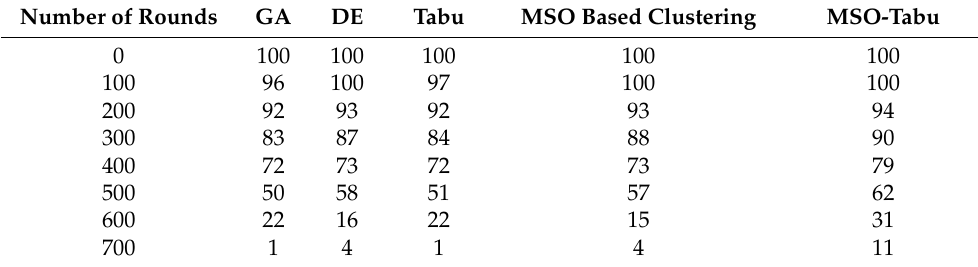
Table 5. Lifetime computation for MSO-Tabu.